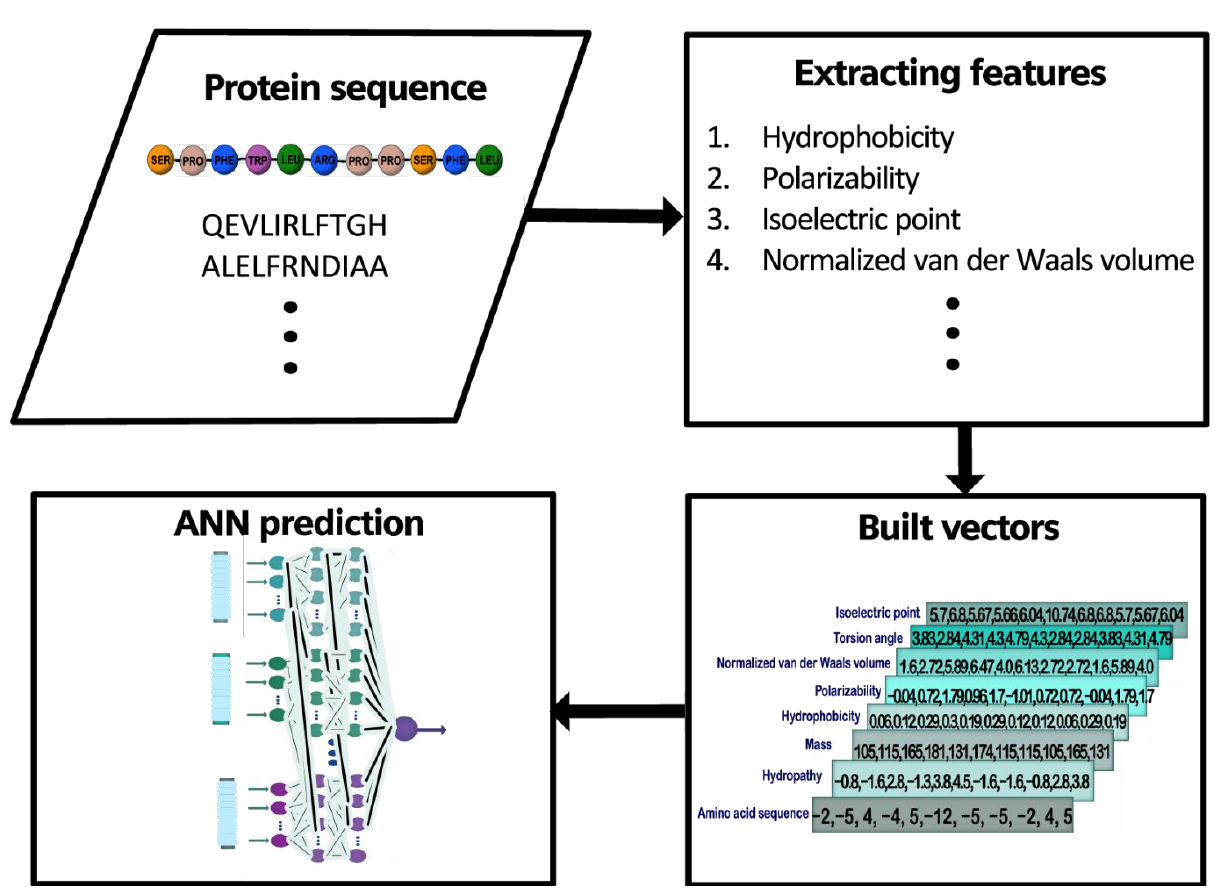
Figure 2. Example of construction of vectors. For the 11mer sequence SPFYLRPPSFL, each amino acid is converted into a number, depending on the property. For example, the first amino acid, serine (SER), has a value of 5.7 for the property isoelectric point, 3.83 for torsion angle, 1.6 for normalized van der Waals volume, −0.04 for polarizability, 0.06 for hydrophobicity, 105 for mass, −0.8 for hydropathy, and −2 for amino acid sequence.